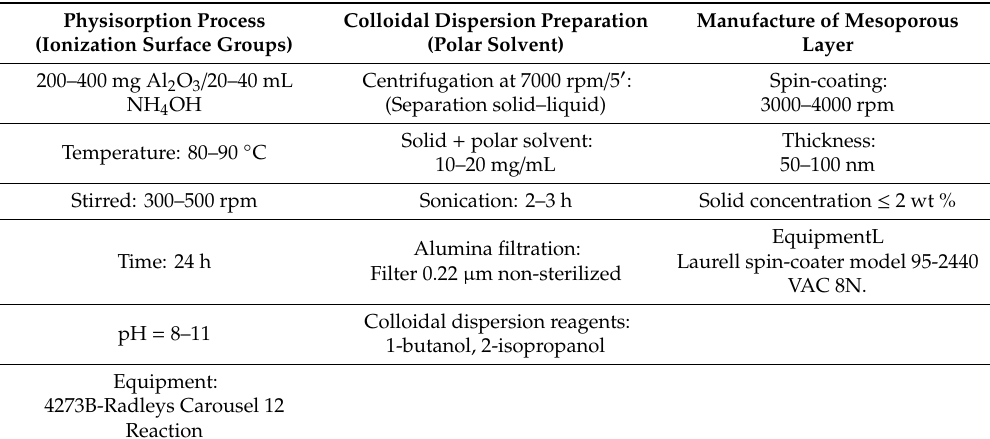
Table 2. Parameters for alumina dispersion preparation and manufacture of mesoporous